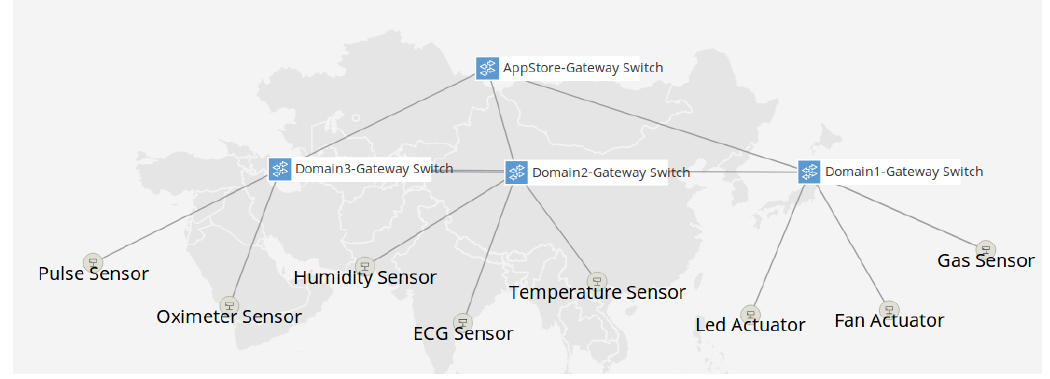
Figure 19. Network topology of the proposed